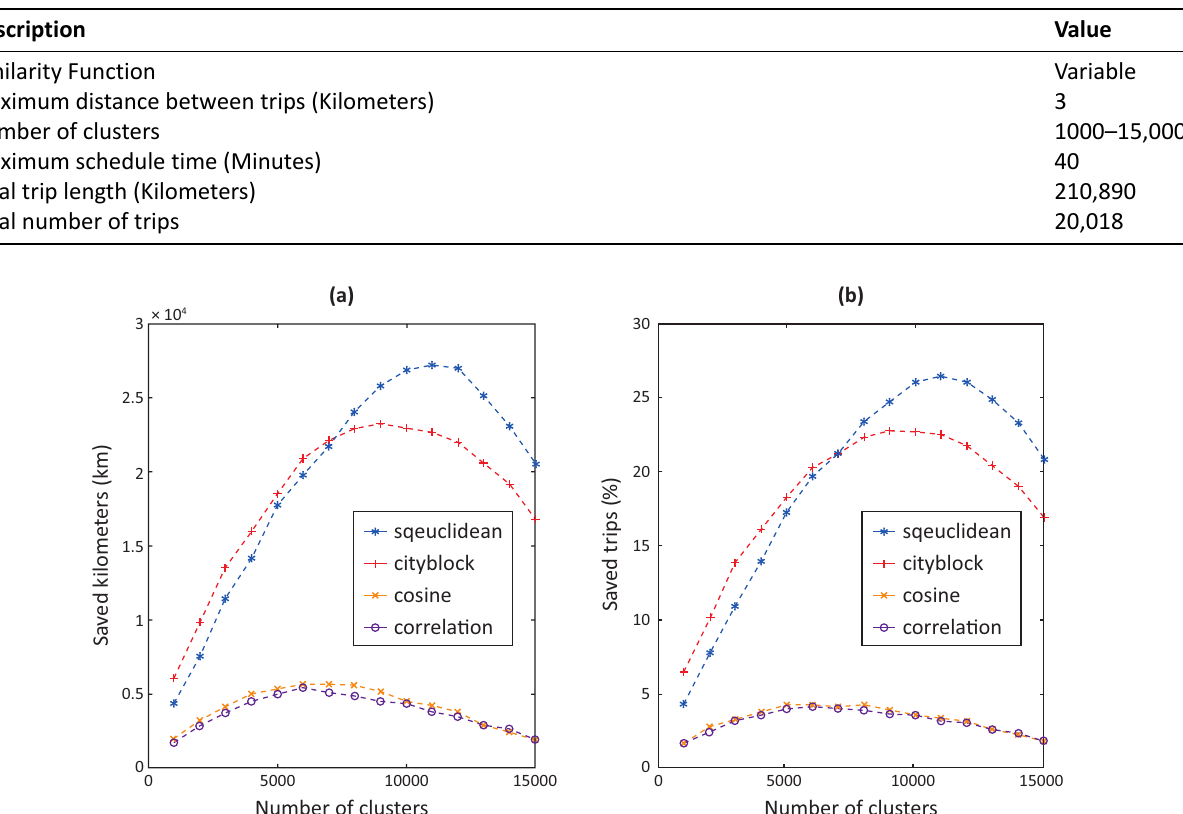
Figure 6. Effect of similarity function and number of clusters on (a) saved kilometers (b) number of saved